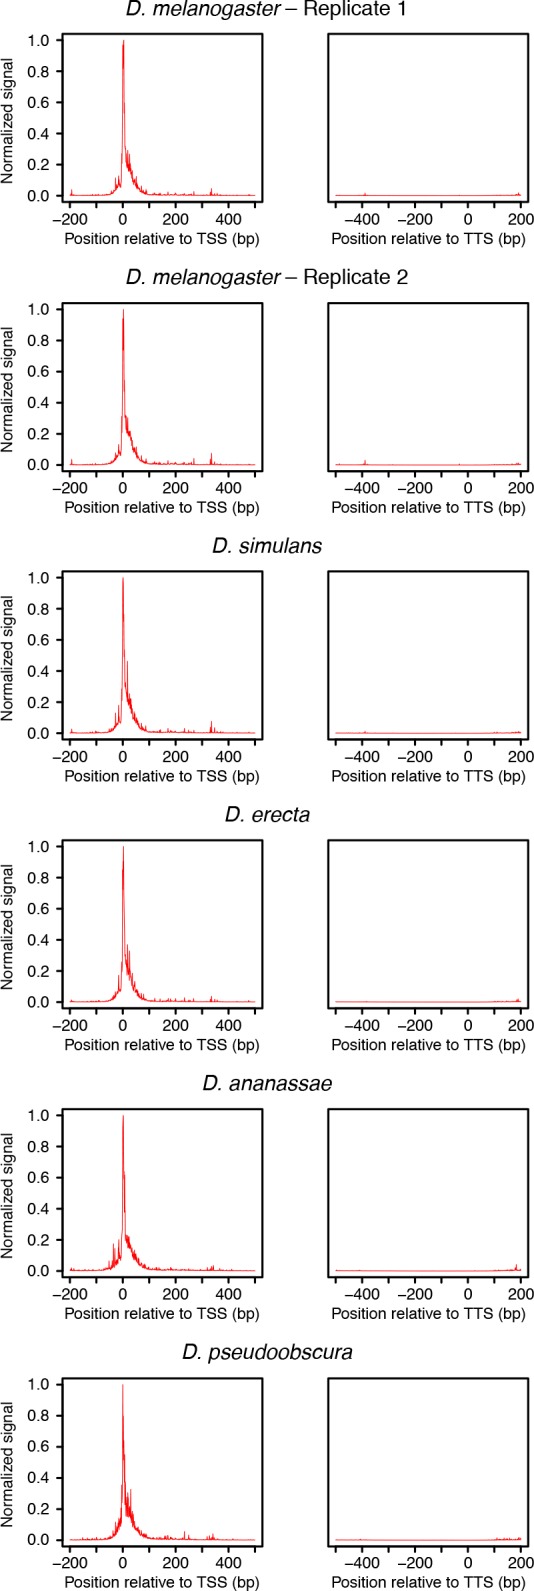
Distribution or raw RAMPAGE signal over transcript annotations.For each species, RAMPAGE reads were mapped to the appropriate genome. The raw 5’ signal was then converted to orthologous D. melanogaster coordinates using chained pairwise alignments from UCSC. Metagene profiles were constructed by summing signal intensity over FlyBase r5.49 mRNA annotations.